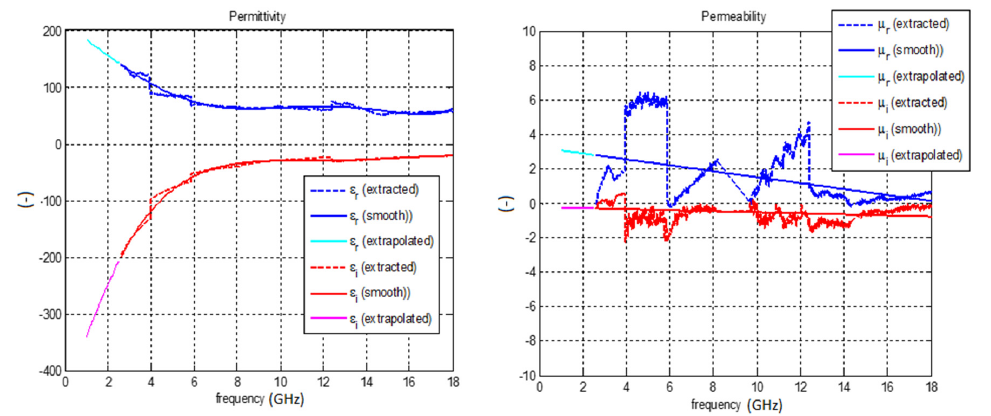
Figure 7. Measured effective permittivity (left) and magnetic permeability (right) of the polymer composite comprising carbon nanotubes and polymer matrix (measurement on the flange of the rectangular waveguide).